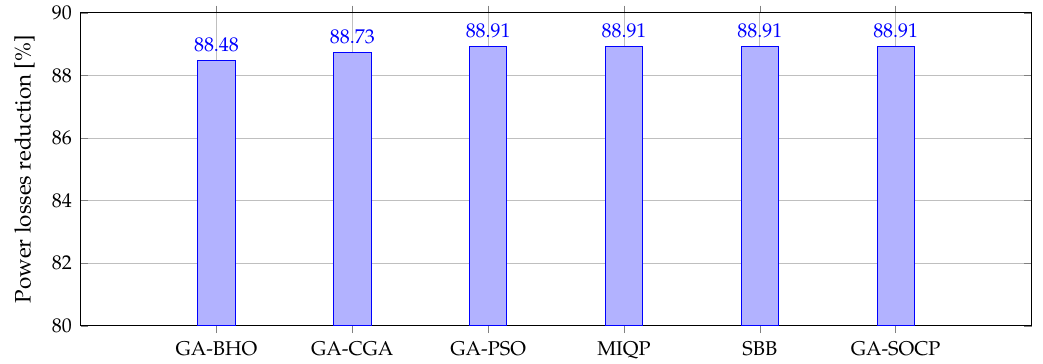
Figure 4. Percentage of improvement regarding power losses minimization in the 21-node test